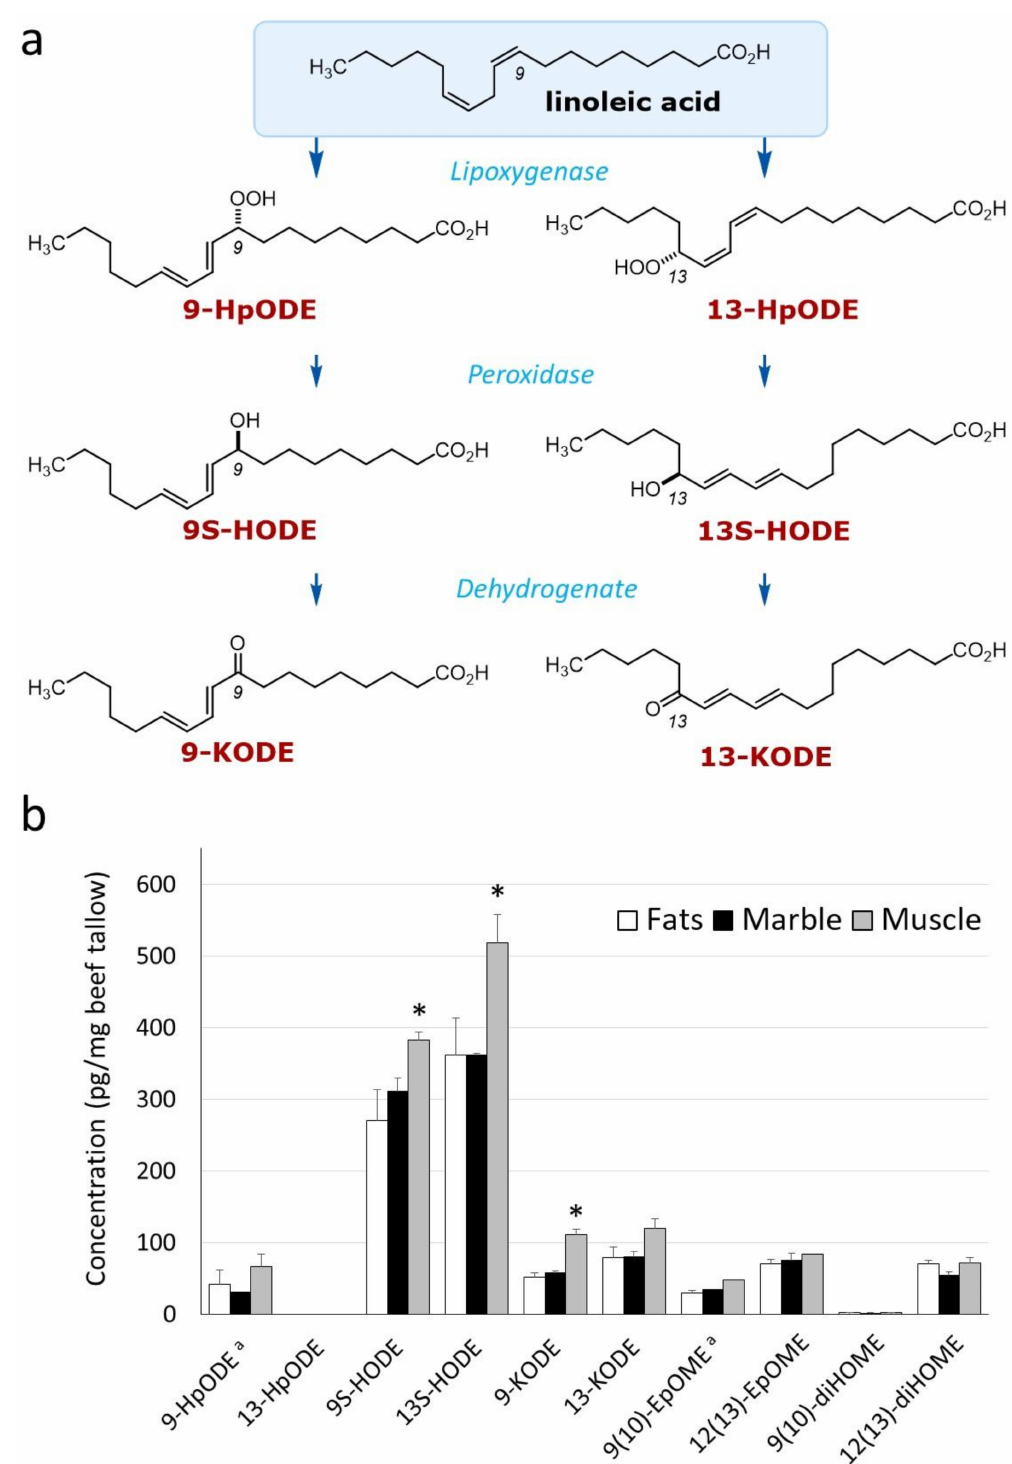
Figure 4. Quantitation of oxidative metabolites of linoleic acid. ( a ) Schematic diagram of lipid oxidation of linoleic acid. ( b ) Composition of oxidized linoleic acid in beef tallow. The graph shows the mean values obtained from three analyses of independently prepared samples. Data represent the mean ± standard error ( n = 3). Significant differences are shown as follows. * p < 0.05 (Tukey’s test; Fats vs. Marble vs. Muscle). a indicates compounds below the lower limit of